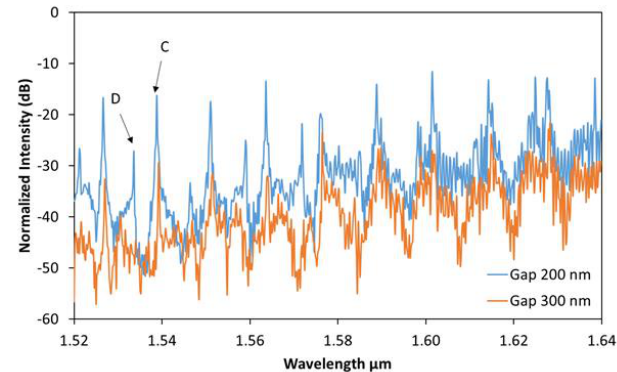
Figure 6. Experimental optical spectrum from the Drop R port for different gap sizes.